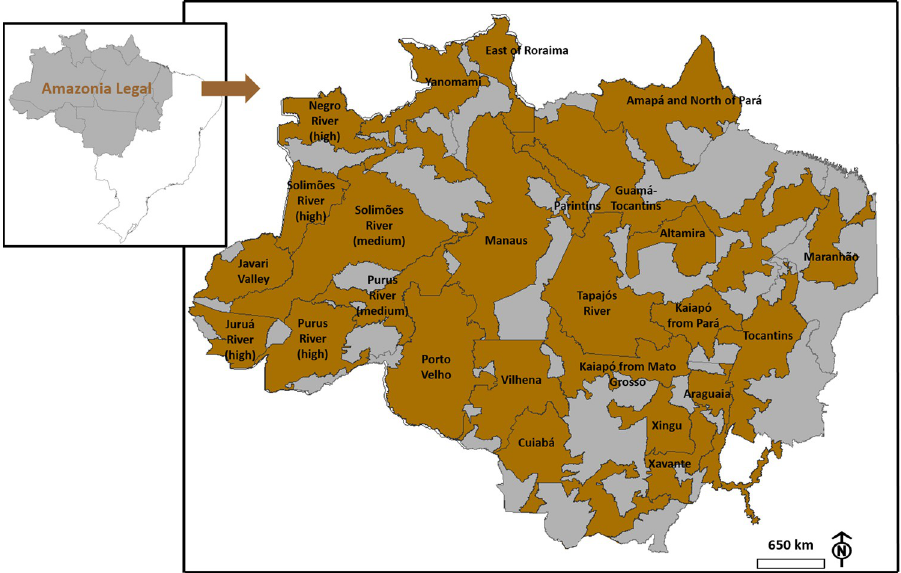
Fig 1. Geographical distribution of the 25 Special Indigenous Health Districts (DSEIs) in Brazil’s Legal Amazon.